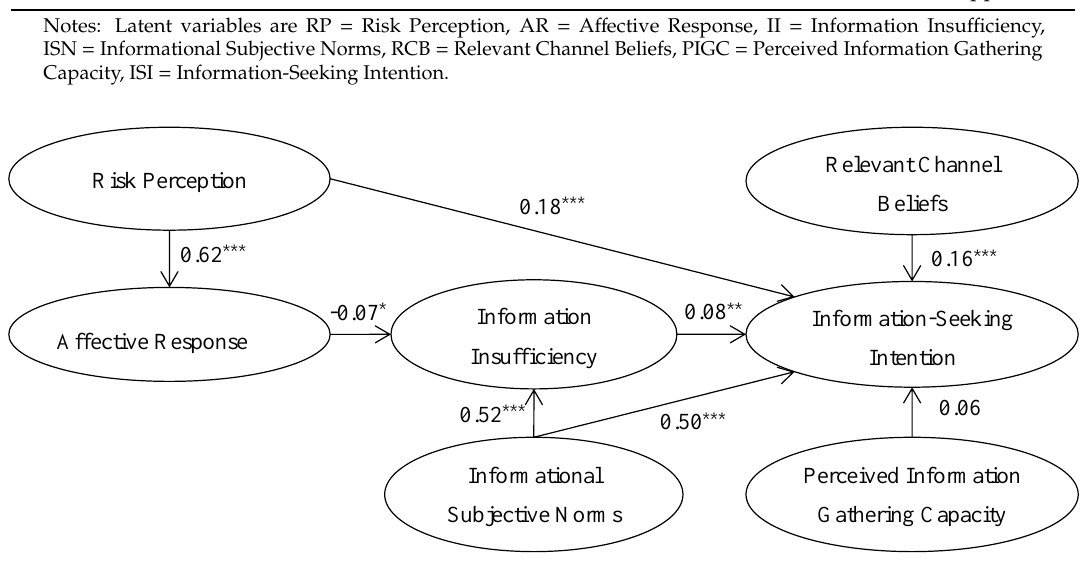
Figure 2. Path coefficients of Structural Equation Model. Figure 2. Path coe ffi cients of Structural Equation Model. Notes: ***, **, and * indicated that p -values are significant at 1%, 5%, and 10% levels,